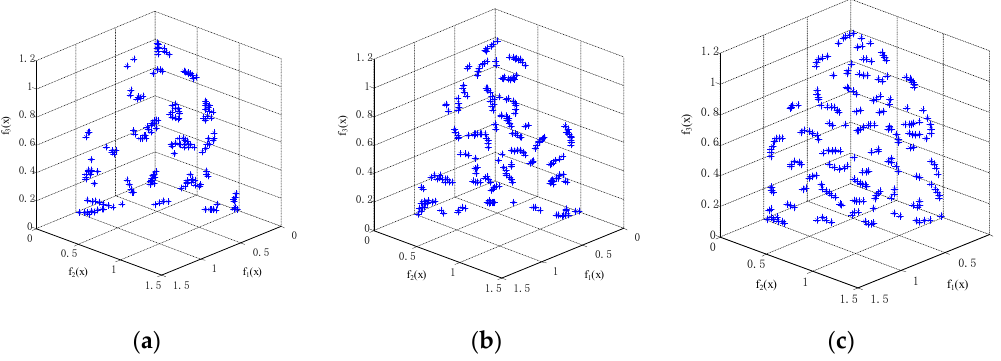
Figure 8. Pareto fronts of DTLZ 2 obtained by ( a ) MOPSO; ( b ) MOGWO; ( c ) HSMGWO.